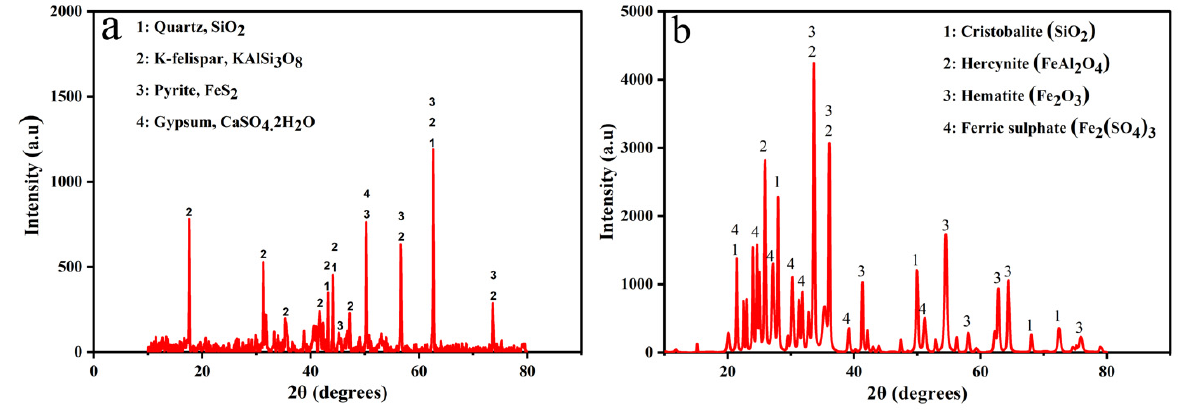
Figure 4. Crystallography of feed material, ( a ) as received sample, and ( b ) after roasting at 500 °C for 2 h.